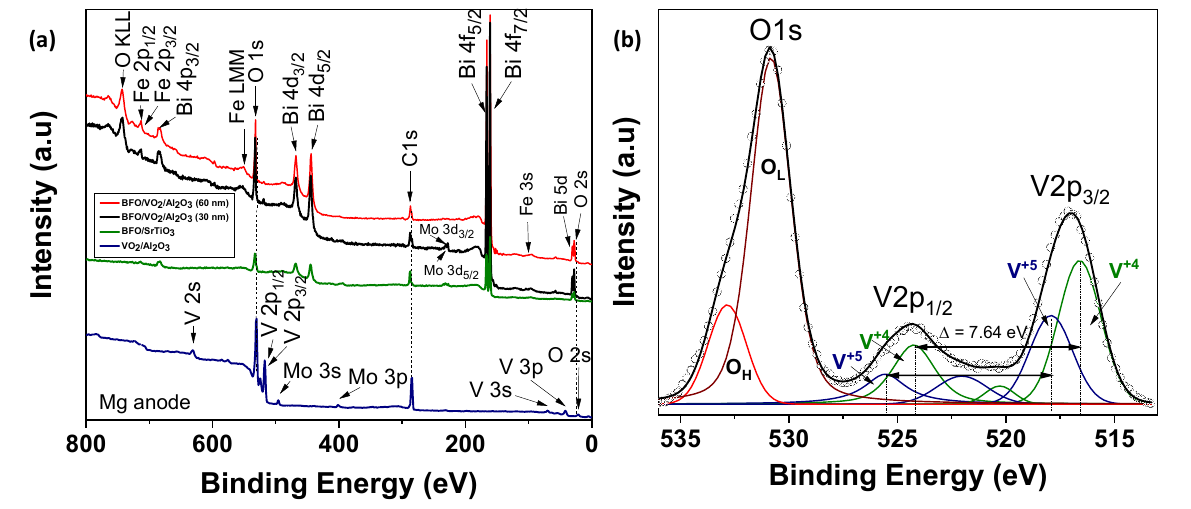
Figure 9. ( a ) The survey scans of the XPS spectra for the monolayers (BFO and VO 2 ) and bilayers (BFO/VO 2 /Al 2 O 3 with BFO 30 nm and 60 nm) ( b ) narrow scan XPS spectrum of VO 2 monolayer.